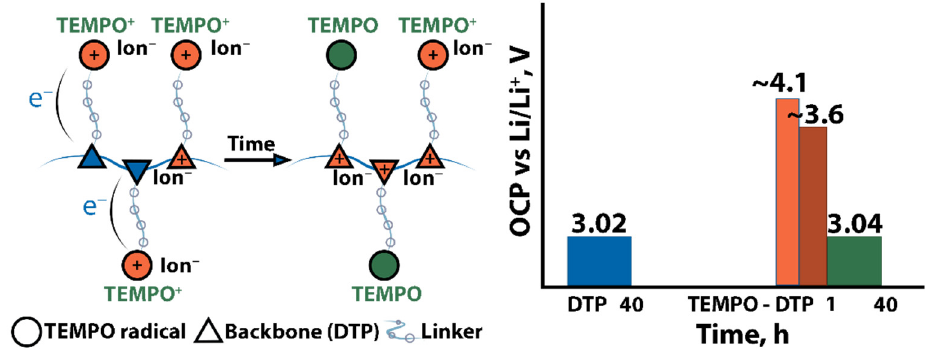
Figure 9. Schematic illustration of internal charge transfer mechanism for TEMPO-containing DTP.